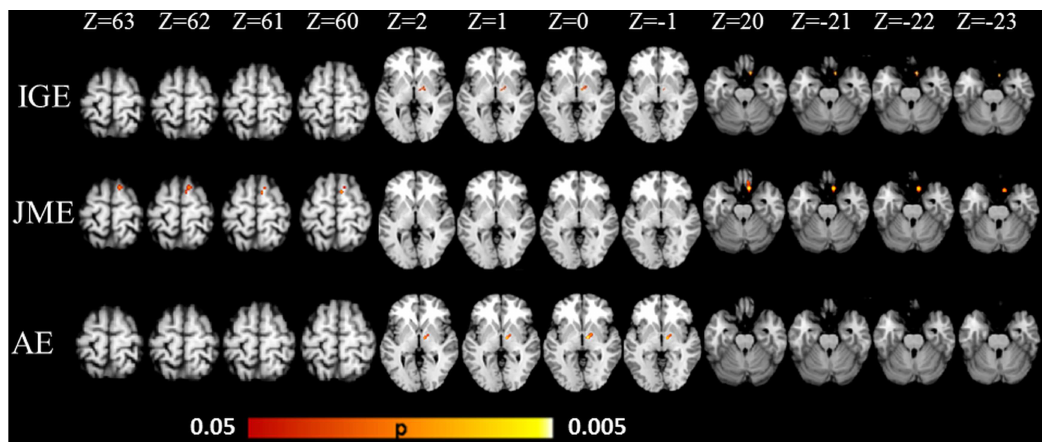
Fig 4. Results of ALE meta-analysis with GMV increase. SignificantGMV increase was found in: for IGE, right ventral lateral nucleusand right medialfrontal gyrus; for JME, right medialfrontal gyrus and right anterior cingulate; and for AE, right ventral lateral nucleus.IGE, idiopathicgeneralizedepilepsy;JME, juvenilemyoclonic epilepsy;AE, absence epilepsy;ALE, activationlikelihood estimation; GMV, gray matter volume.